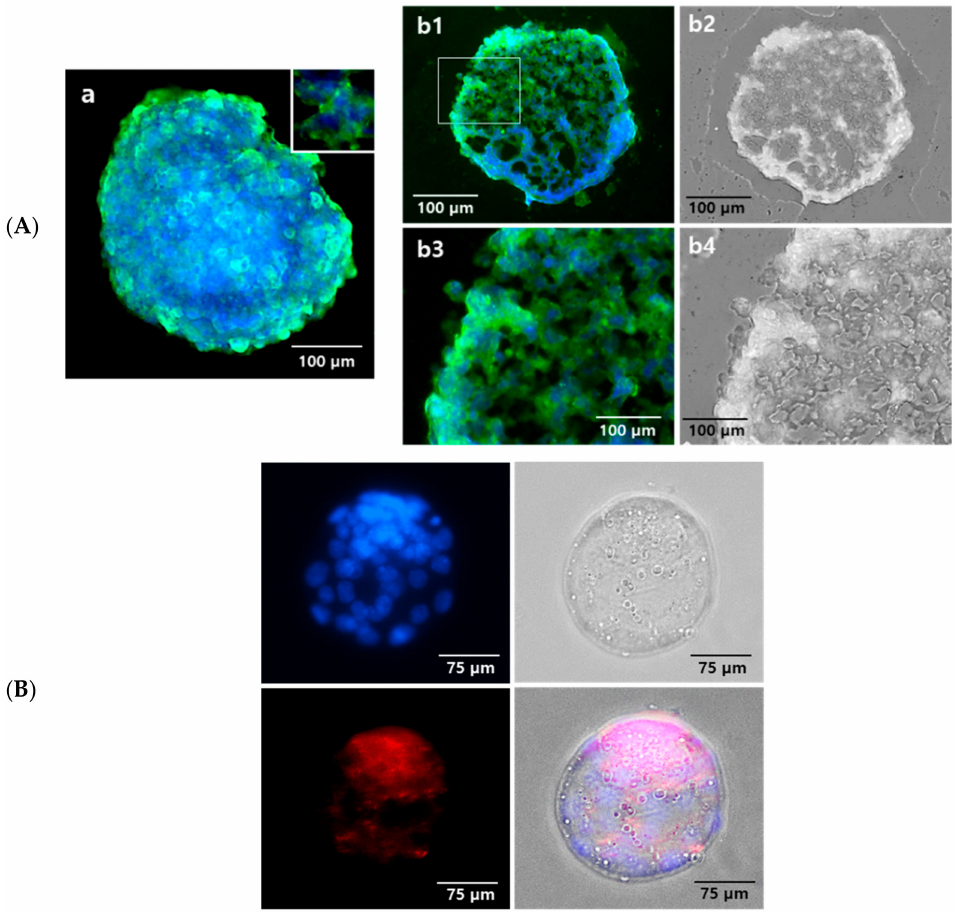
Figure 3. Expression of progesterone receptor (PR) on the day 9 hEBs and mouse BLs. ( A ) Suspended hEBs were fixed and immunostained with PR-specific antibody (green fluorescence). a: PR expression on the surface of hEB. Pictures with higher magnification represented in inner box. b1, b3: PR expression on the cross-sectioned hEB. b2, b4: phase-contrast microscopic image. ( B ) The expression of PR was confirmed in mouse embryo. Red fluorescence represented PR expression, and nuclei were stained with 4 (cid:48) ,6-diamidino-2-phenylindole (DAPI) and are represented as